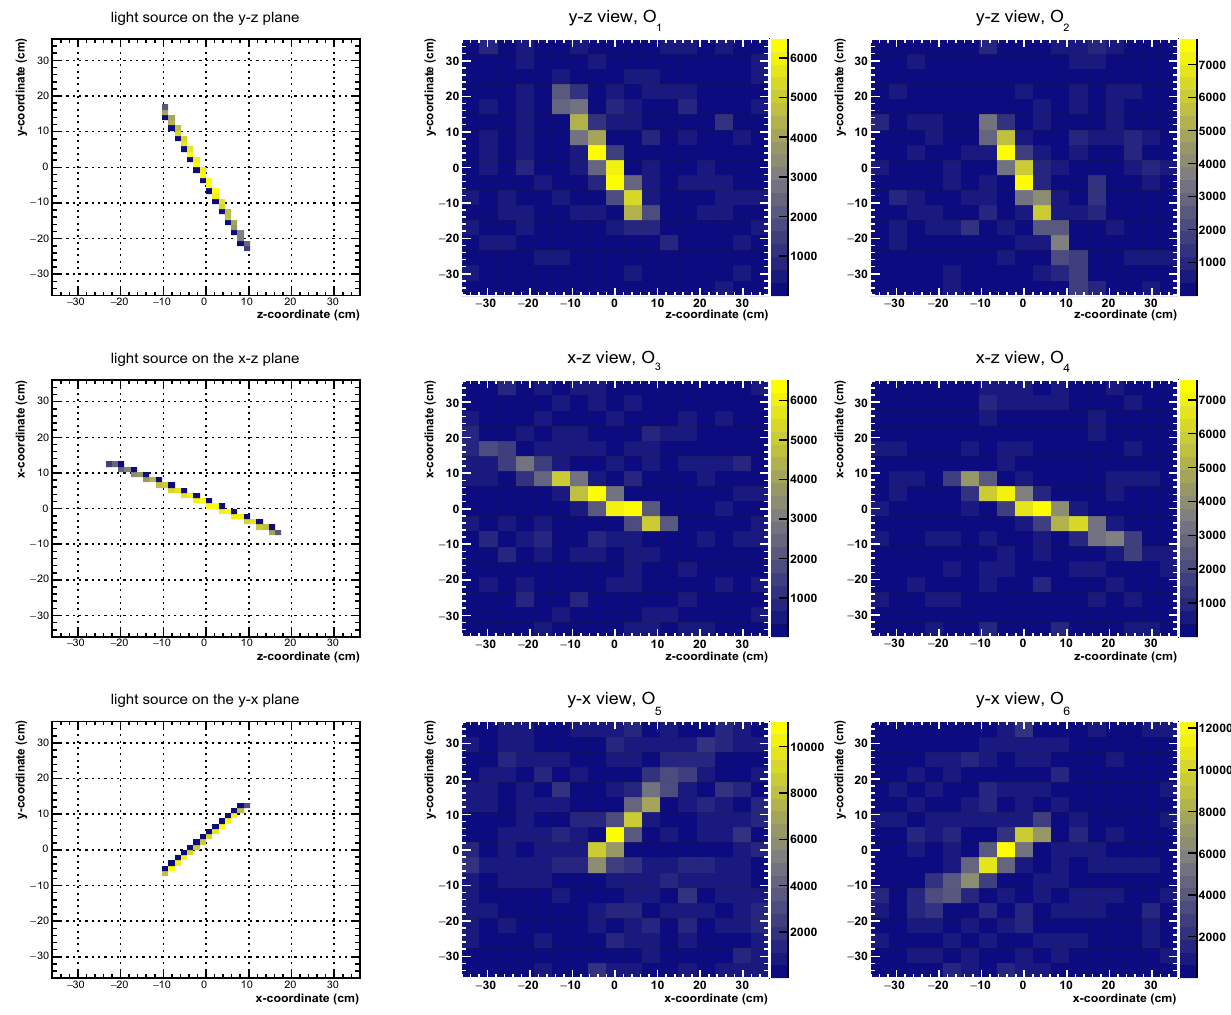
Fig. 6 Left column The light track crossing is shown in real dimensions in three different views. Central and right columns Reconstruction of the light track on three couples of parallel detectors. The experimental setup is that in